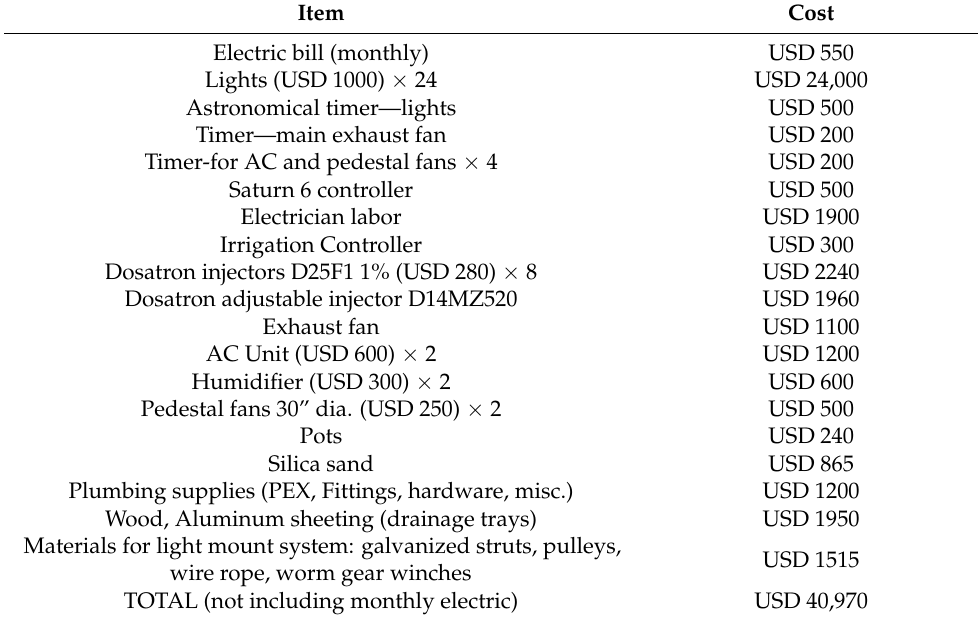
Table 2. Costs (USD) associated with components of grow-room construction, including monthly electric